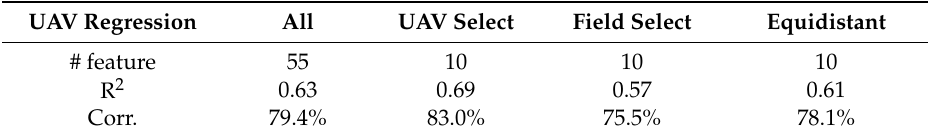
Table 5. Performance of the di ff erent feature sets for the YR regression based on UAV observations. UAV